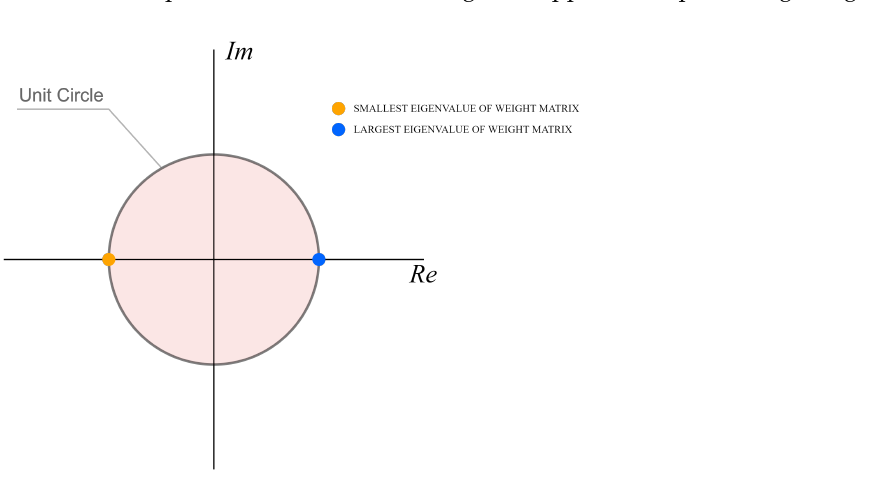
Figure 8. Location of largest and smallest eigenvalue of weight matrix if maximum-degree weights are